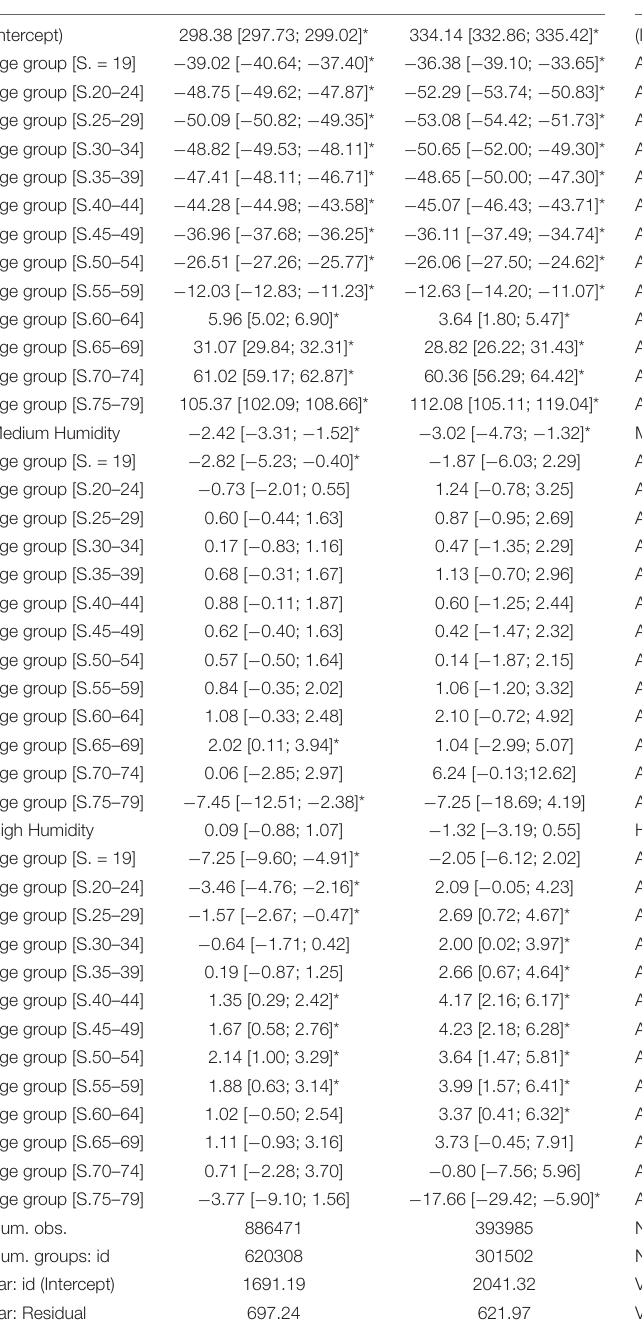
TABLE 3 | Linear mixed model for race time with age group and humidity interaction. Men